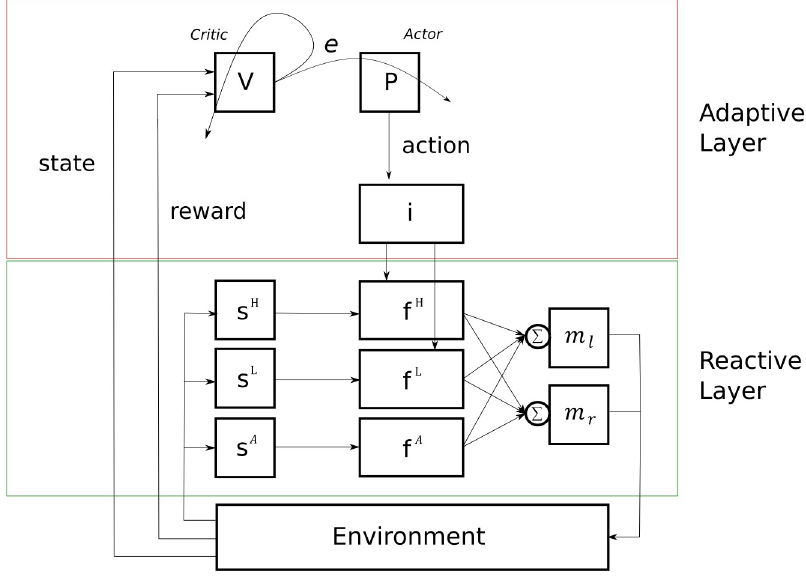
Fig 2. Representation of the Control-based Reinforcement Learning (CRL) model. On top, the Adaptive Layer (reinforcement learning control loop) composed of a Critic or value function ( V ), an Actor or action policy ( P ), and an inhibitor function ( i ). At the bottom, the Reactive Layer (sensorimotor control loop), composed of three sets of sensors s H , s L , s A , (corresponding to High/Low reward and the other Agent, respectively), three functions f H , f L , f A (corresponding to High/Low reward seeking and collision avoidance behaviors, respectively) and two motors m (corresponding to the left and right motors). The action selected by the AL is passed through the inhibitor function that will turn off one of the attraction behaviors of the RL depending on the action selected. If the action is go to the high , the low reward seeking reactive behavior will be inhibited. If the AL selects go to the low , the RL will inhibit its high reward seeking behavior. If the AL selects none , the RL will act normally without any inhibition.